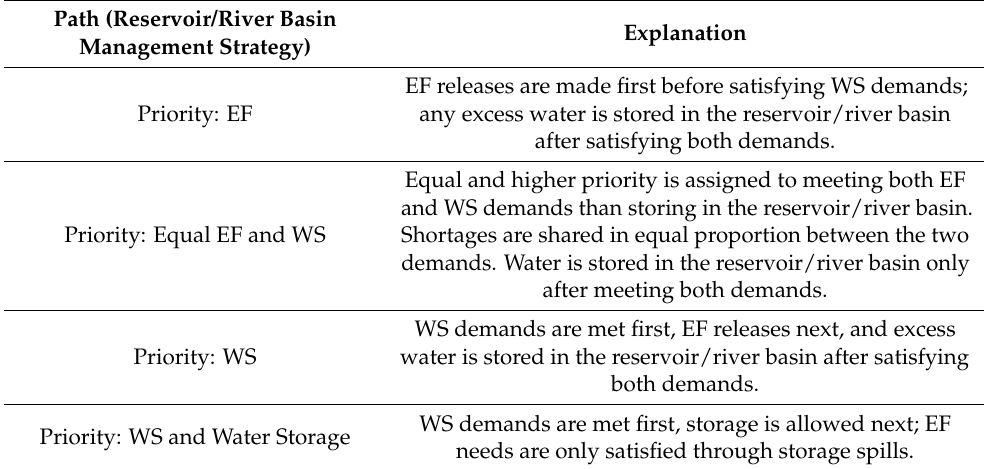
Table 3. Reservoir and river basin management strategies through which water supply (WS) and environmental flow (EF) demands can be fully or partially met (see Figure